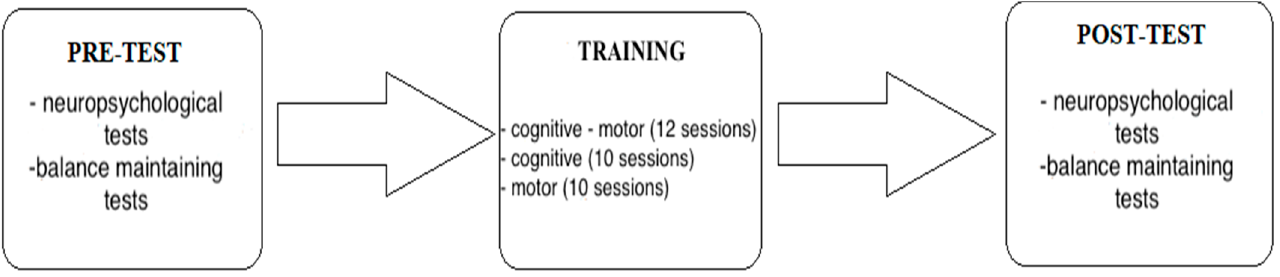
Figure 1. General scheme of the